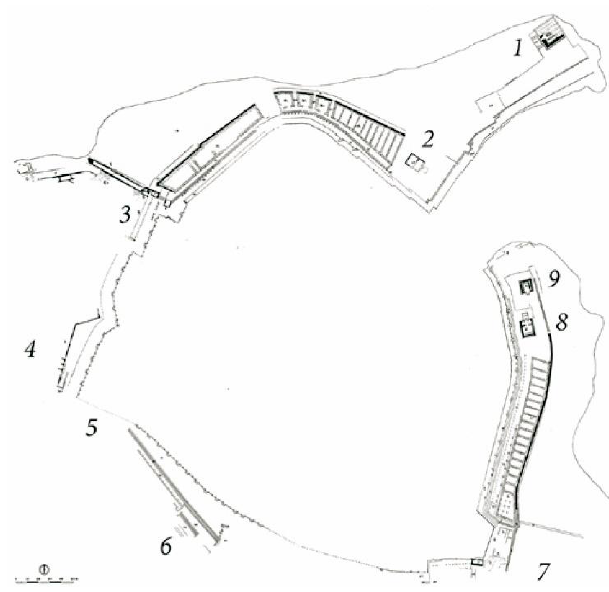
Figure 16. Port of Leptis Magna [26] (p. 266, Figure 2).